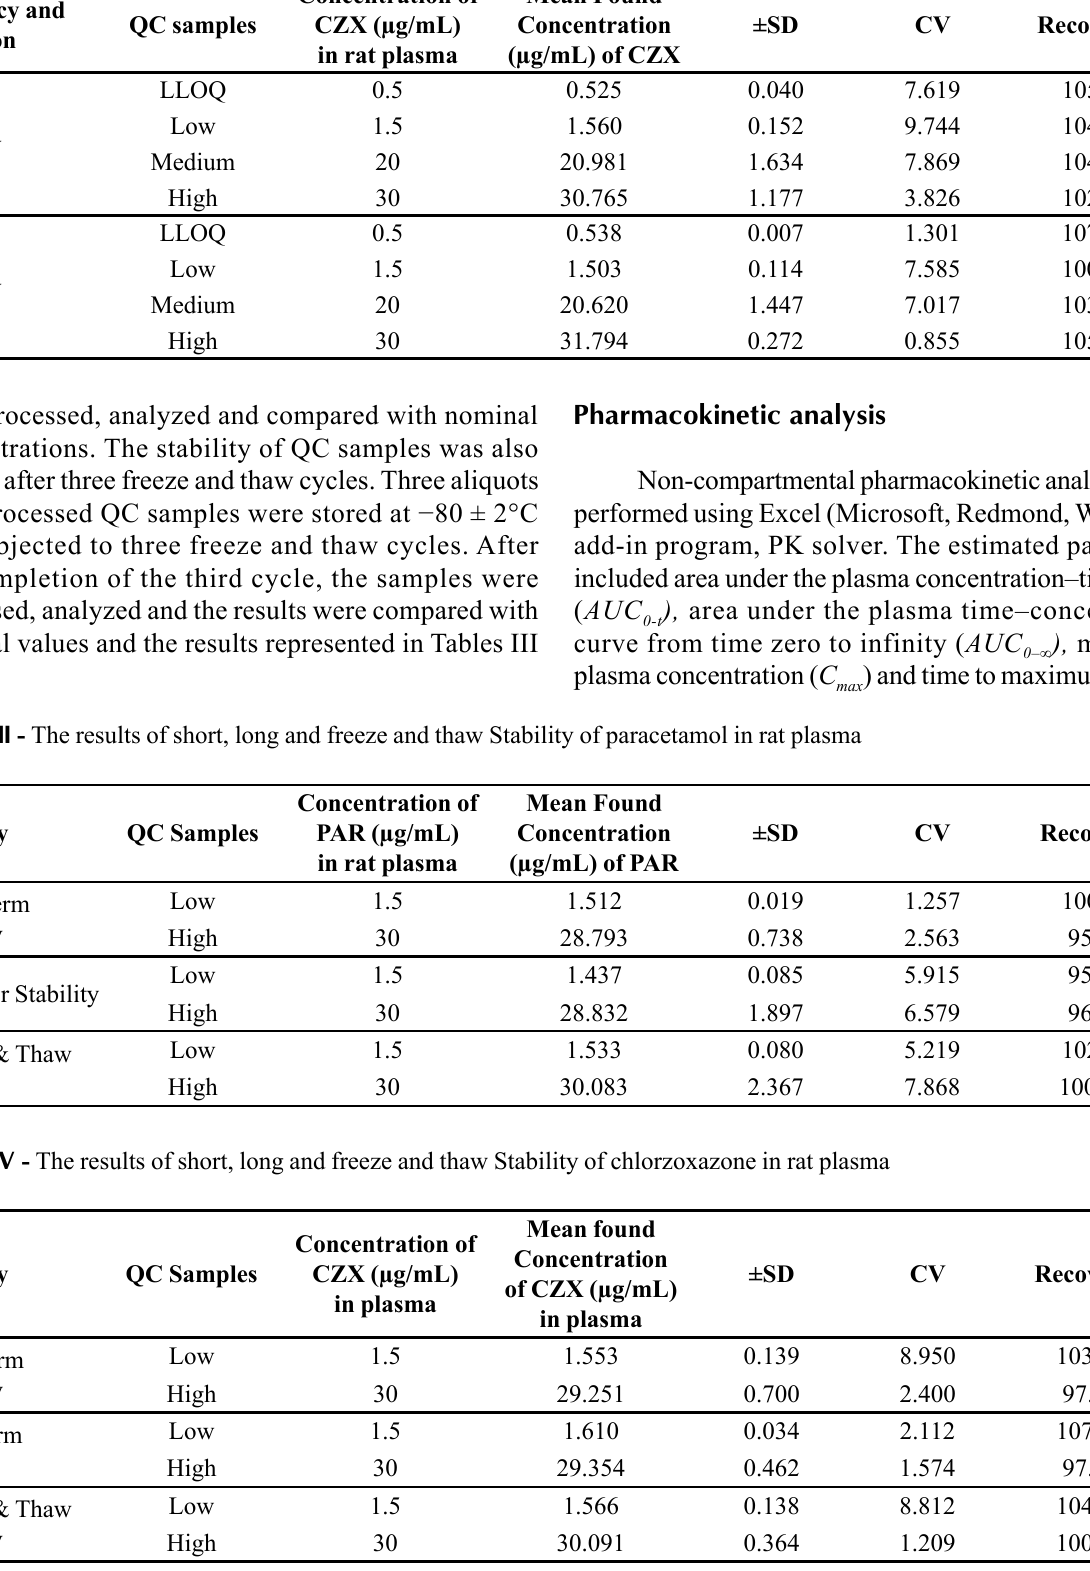
TABLE II - The results of intra- and inter-day accuracy and precision for the determination of chlorzoxazone in rat plasma Accuracy and Precision